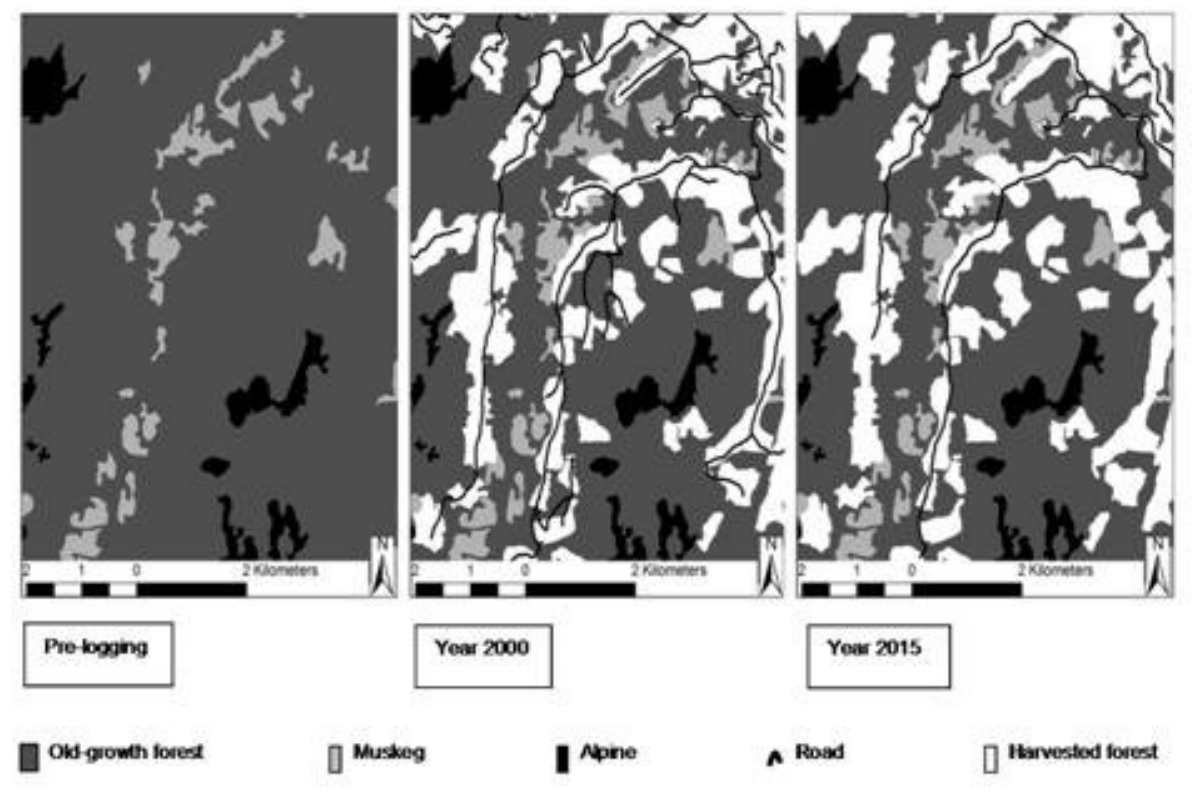
Fig. 2 . Map of common landscape change between 1950 and 2015 within a watershed on Prince of Wales Island, Alaska. Map “2015” was based on projected road closures and harvest